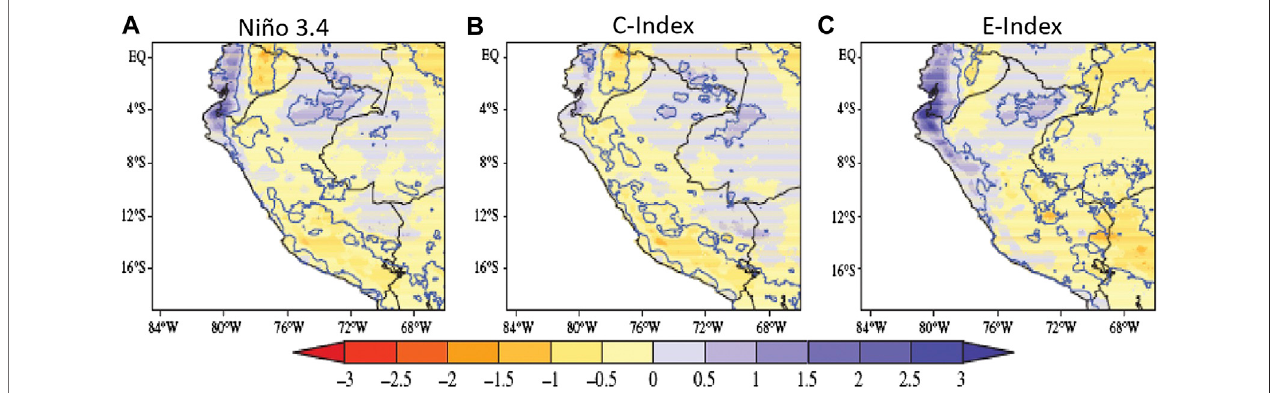
FIGURE 8 | Linear regression coef fi cients between ENSO indices (Niño 3.4, C-El Niño Modoki, and E-Canonical El Niño) and PISCO precipitation data ( A – C , respectively)in thesouth tropical Andes. Values are inmm day − 1for onestandarddeviationofeach corresponding ENSO index. Blue (Red)shadingrepresents positive (negative) precipitation anomalies in intervals of 0.5 ( − 0.5) mm day − 1 per standard deviation. Black contour represents the climatological isoline of 4 mm day − 1. Blue contoursrepresentsigni fi cantcorrelationbetweenENSOindicesandprecipitationatthe95%con fi dencelevel.Analysisbasedontheperiod1980 – 2016.Adapted from Sulca et al. (2017). © International Journal of Climatology. Reprinted by permission from John Wiley and Sons.